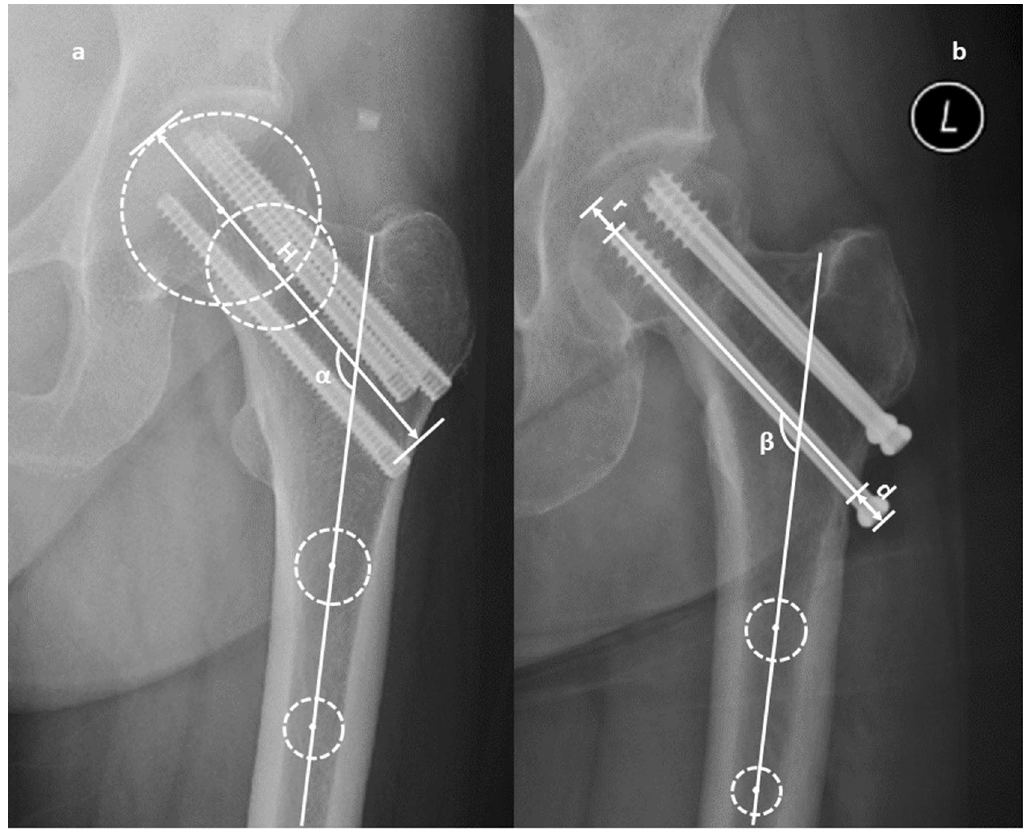
Figure 1. Imaging measurement after FNF cannulated screw fixation. ( a ) The measurement of the length of the femoral neck axis and the neck-shaft angle. H was the length of the femoral neck axis, and α was the neck-shaft angle. ( b ) The distance from the screw head to the femoral head cortex and the distance between the screw tail and the lateral cortex. The average screw migration distance and the average screw back-sliding distance can be obtained by calculating the difference. (The figure was created using Microsoft Office 2019, see aka.ms/